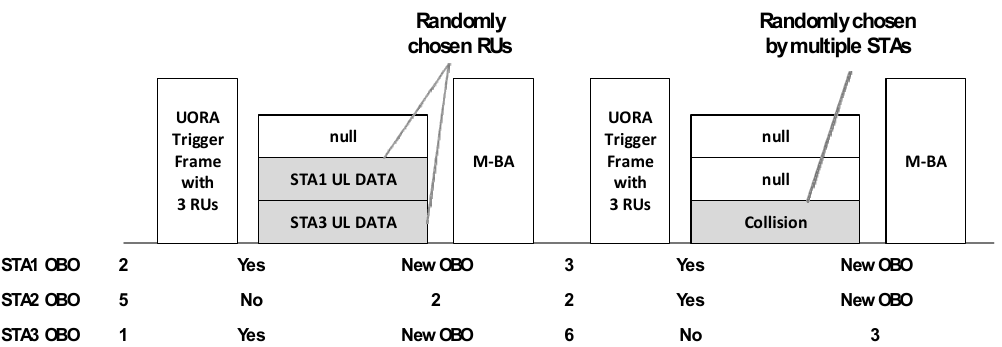
Figure 6. Basic concept and operation of uplink OFDMA random access (UORA) procedure.